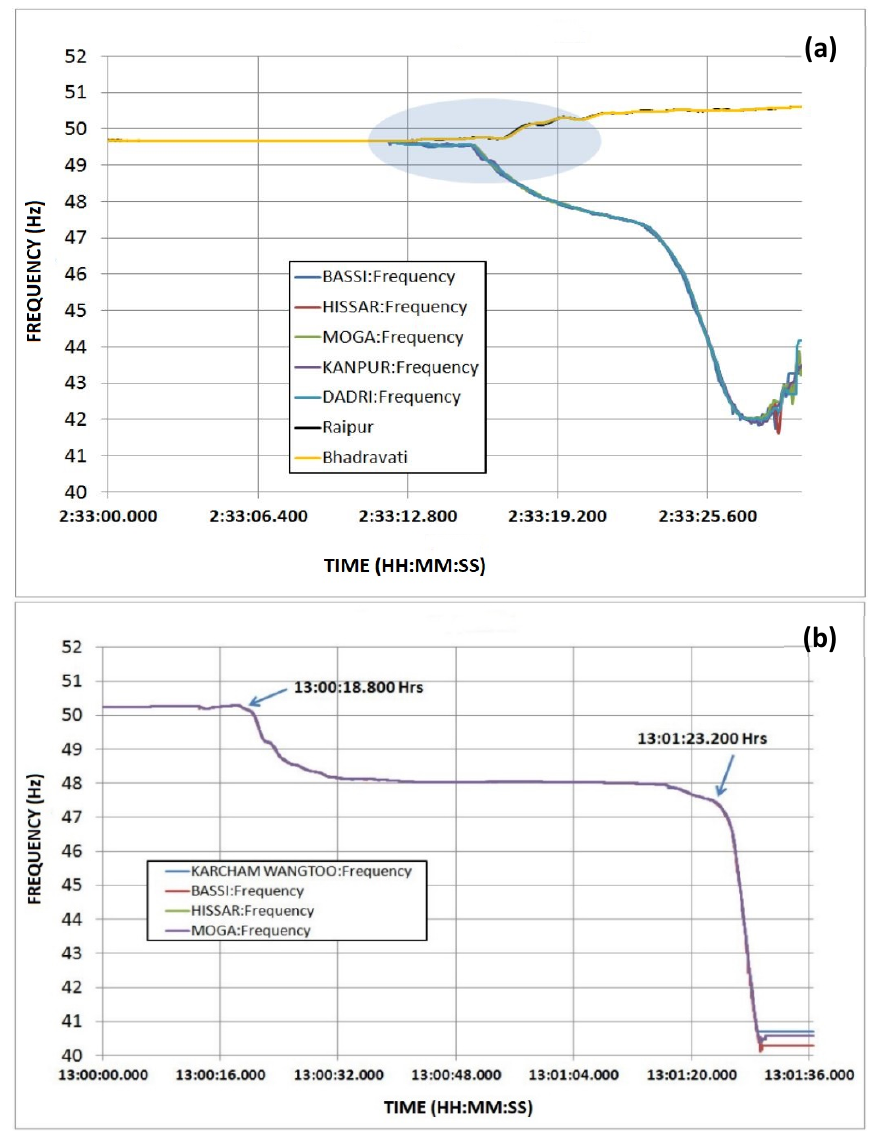
Figure 7. Frequency dynamics at different locations during the blackouts in India ( a ) on 30 July and ( b ) on 31 July [87].